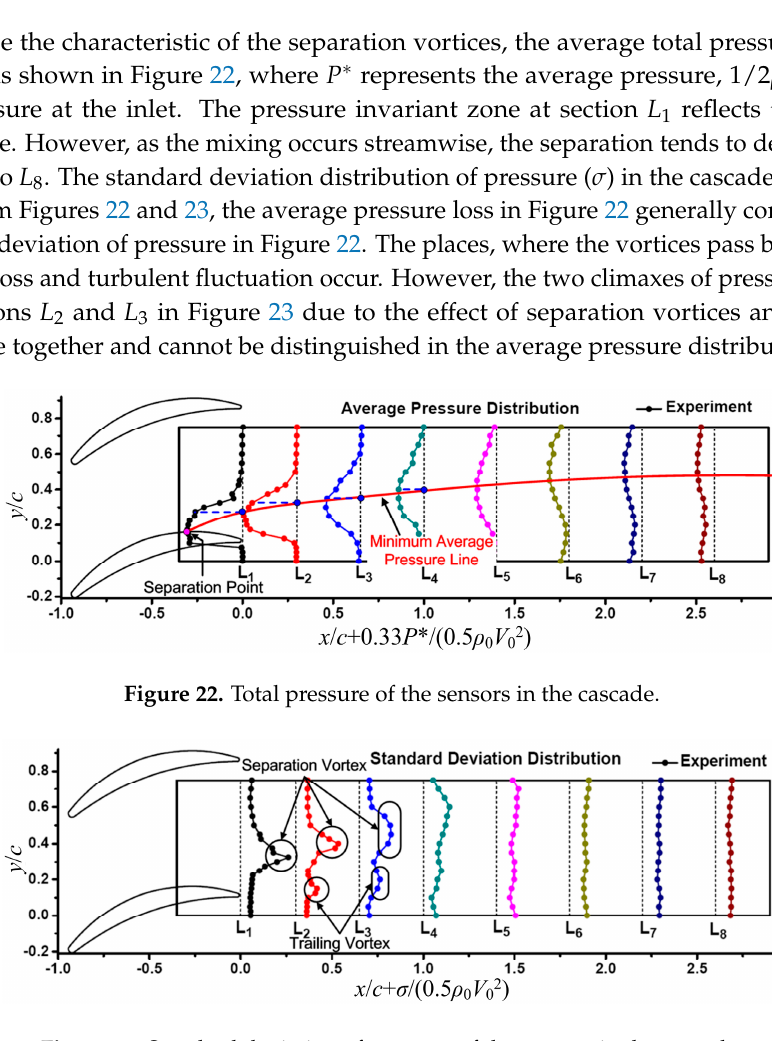
Figure 23. Standard deviation of pressure of the sensors in the cascade.